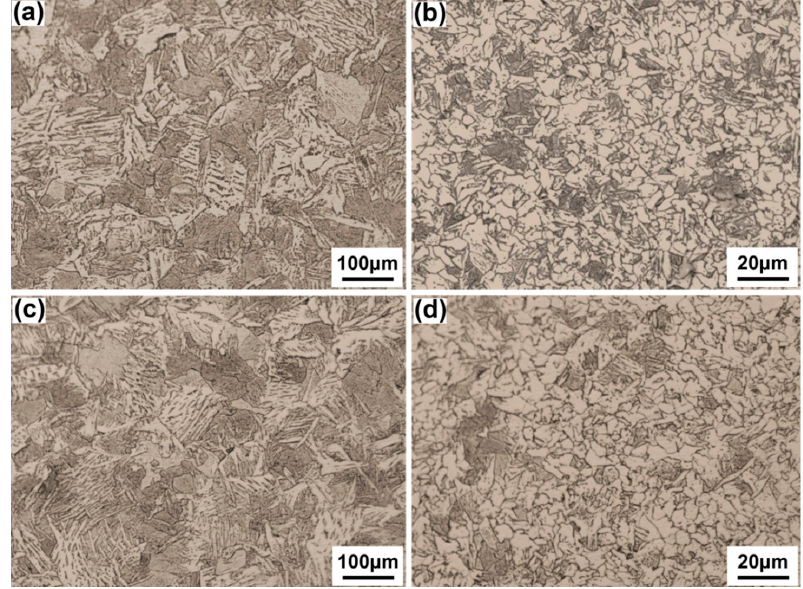
Figure 6. Microstructure of heat affected zones (HAZ), ( a ) coarse grain zone of root layer; ( b ) fine grain zone of root layer; ( c ) coarse grain zone of filler layer; ( d ) fine grain zone of filler layer.